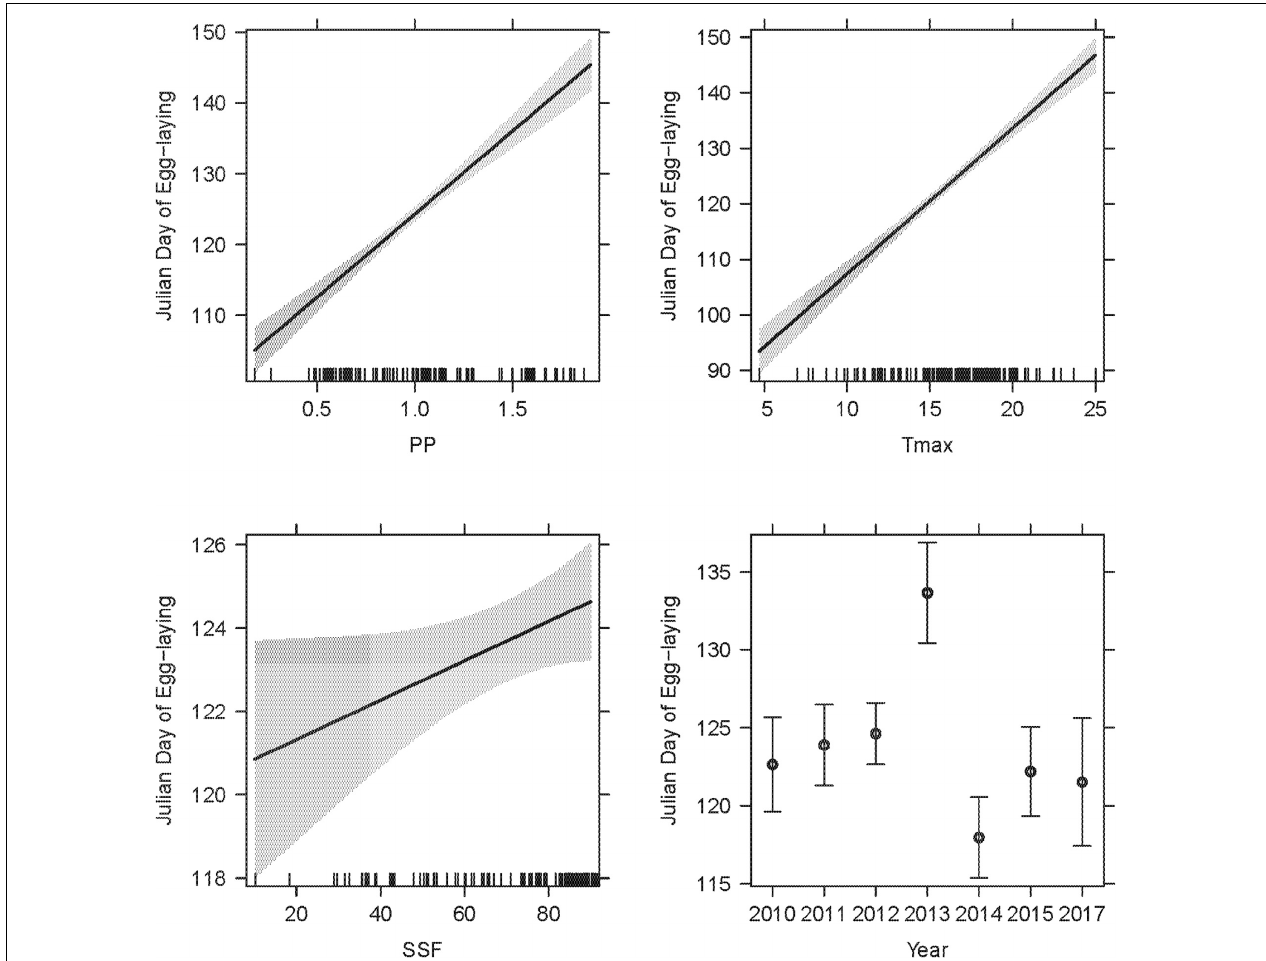
FIGURE 5 | The LMM on egg-laying dates featured two weather variables (PP, T max ), year, SSF and observer category (not depicted) as significant explanatory terms. The overall R 2 LMMc was 0.77. Model details in Table 1B